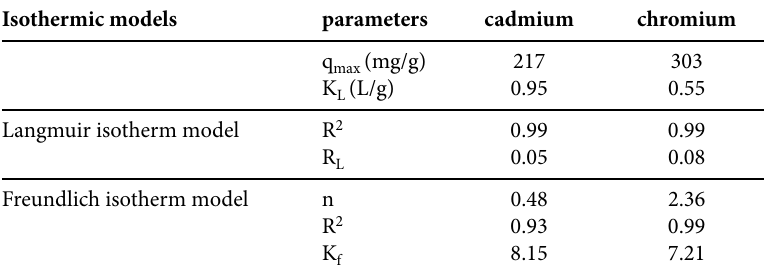
Table 2: Langmuir and Freundlich isotherm constants for adsorption of cadmium (II) and chromium (III) using CFNC from aqueous solutions. Isothermic models